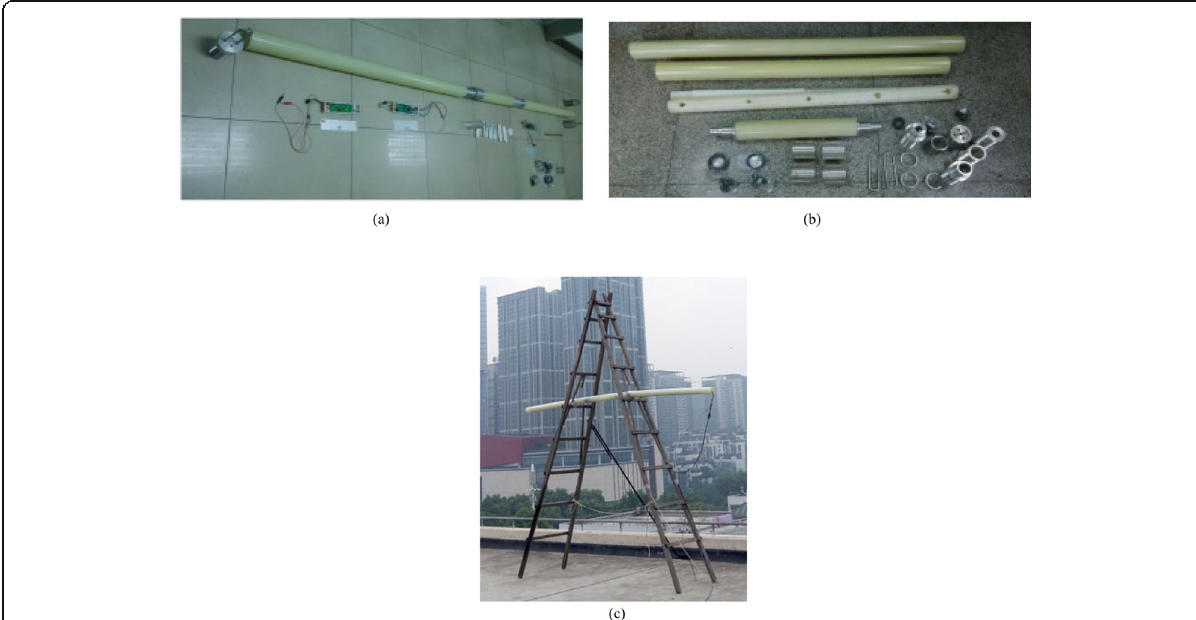
Fig. 5 The material object of the mechanical structure design of the drilling and logging radar. a The material object illustration. b The main mechanical structural components of the radar system. c The complete system photos